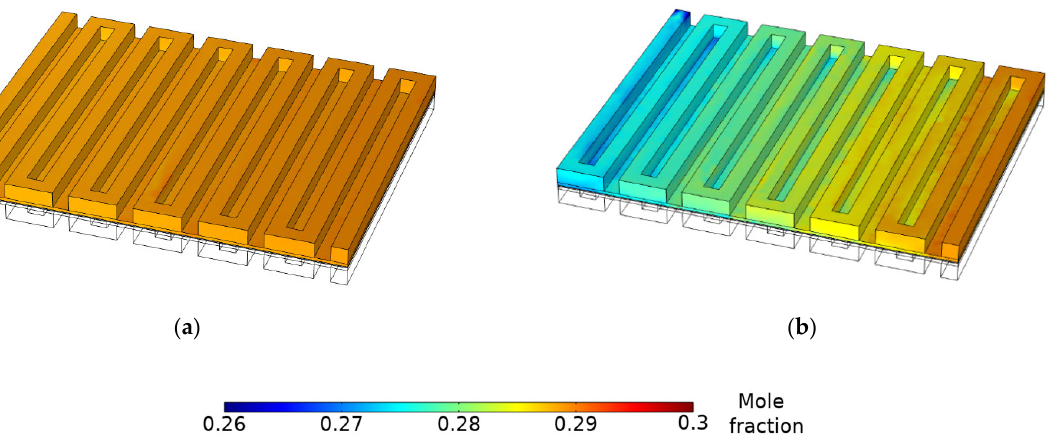
Figure 7. Oxygen mole fraction distribution at the cathode for cell voltage of ( a ) 0.75 V and ( b ) 0.25 V.